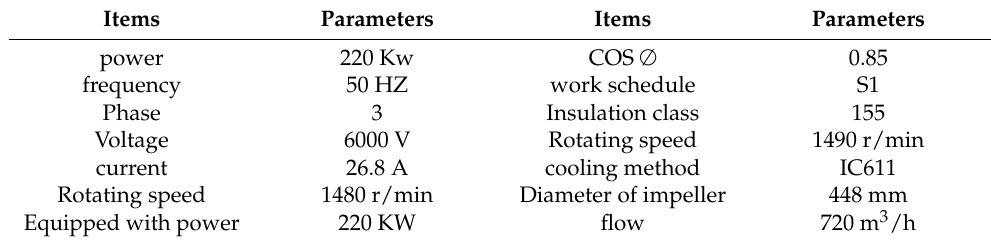
Figure 7. Water pump set equipment structure and vibration sensor installation physical diagram. ( a ) Left side view of position 2 of the drive end of the drive motor; ( b ) Schematic diagram of the overall connection of the water pump; ( c ) Physical map of position 2; ( d ) Physical map of position 4; ( e ) Physical map of position 3; ( f ) Physical map of position 1. Table 2. Pump-related technical